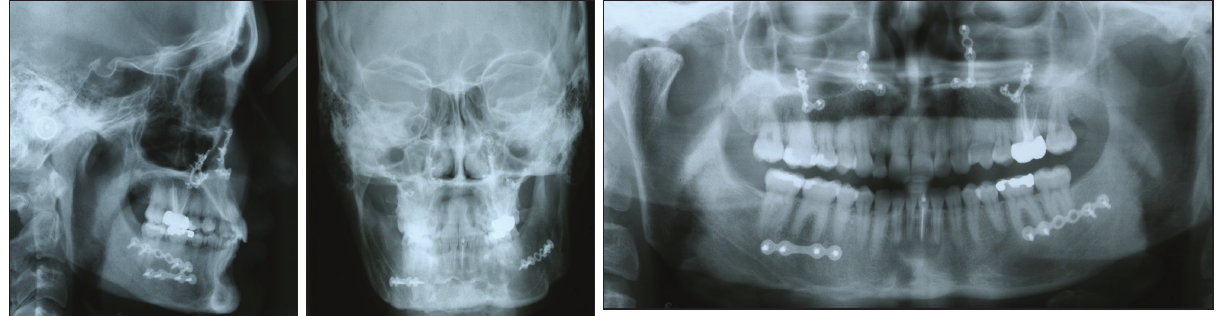
Figure 4d. Seven-year post-treatment panoramic.